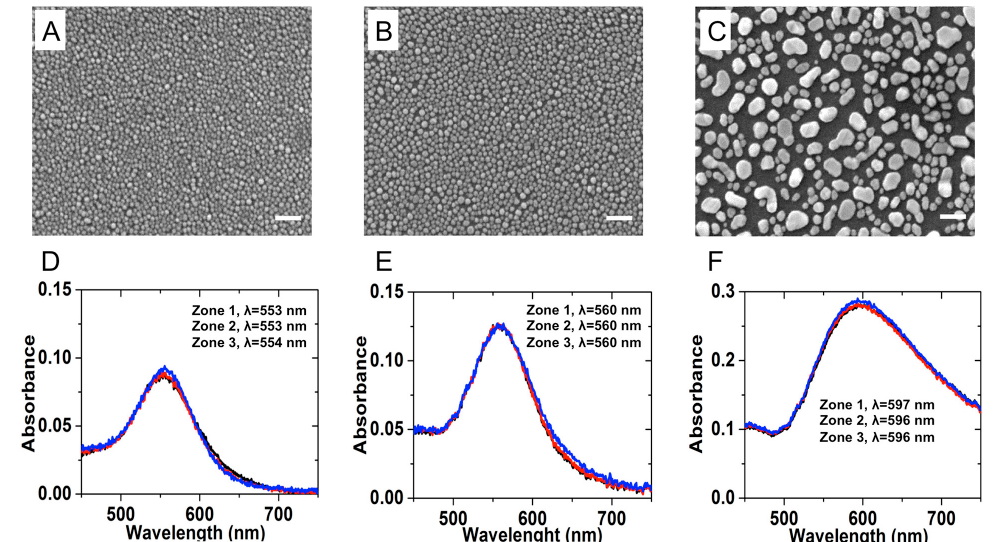
Figure 4. Scanning electron microscope (SEM) images of different gold nanoparticle substrates. The initial gold film thickness was ( A ) 3 nm for sample 1; ( B ) 5 nm for sample 2 and ( C ) 12 nm for sample 3. Scale bar is 100 nm. Extinction spectra of ( D ) sample 1; ( E ) sample 2 and ( F ) sample 3 are presented below corresponding SEM images. Red, blue and black lines present spectra collected from three different zones on each sample. The morphological and optical properties of each sample are listed in Table 1.